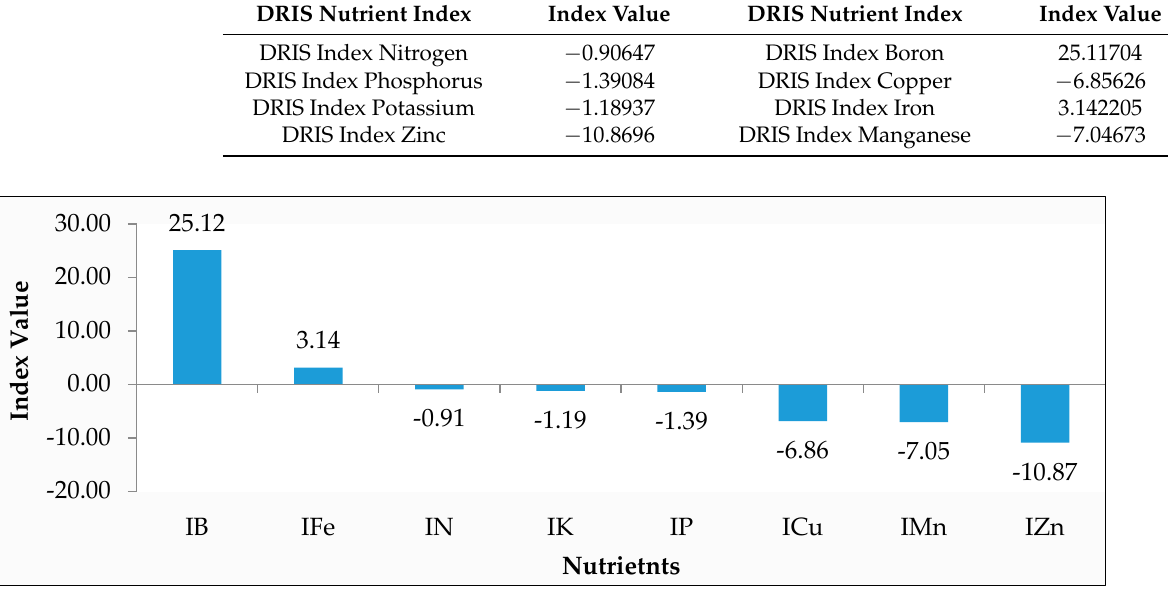
Figure 2. Nutrient index value for olive